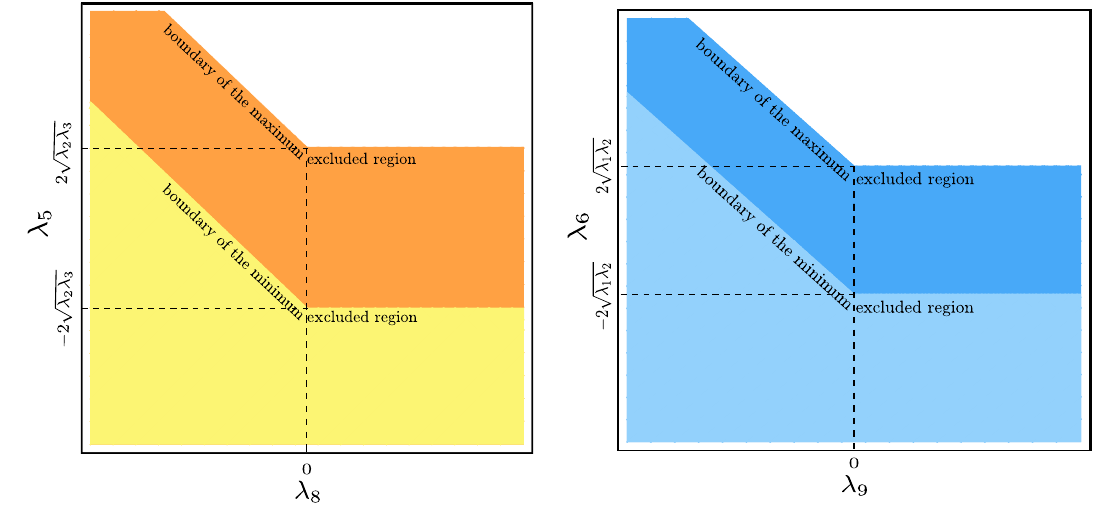
Fig. 3 Maximum and minimum excluded regions in the λ 5 − λ 8 (left) and λ 6 − λ 9 (right) parameter space. In general, the maximum and minimum excluded regions for λ 5 ( λ 6 ) depend on the sign of λ 8 ( λ 9 ) as explained in the text